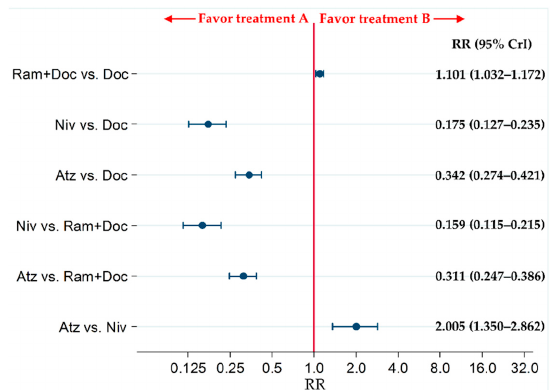
Figure 7. Comparative safety of the four therapeutic regimens, Ram+Doc, Doc, Niv, and Atz, pertaining to grade 3–5 treatment-related adverse events in patients with refractory or relapsed advanced non-small-cell lung cancer. The patient inclusion criteria for all RCTs in this analysis did not place any limitations on PD-L1 status. Comparisons are expressed as treatment A versus treatment B. Data are presented as RRs and 95% CrIs. Ram+Doc (ramucirumab plus docetaxel); Niv (nivolumab); Atz (atezolizumab); Doc (docetaxel); RR ( risk ratio); CrI (credible interval).